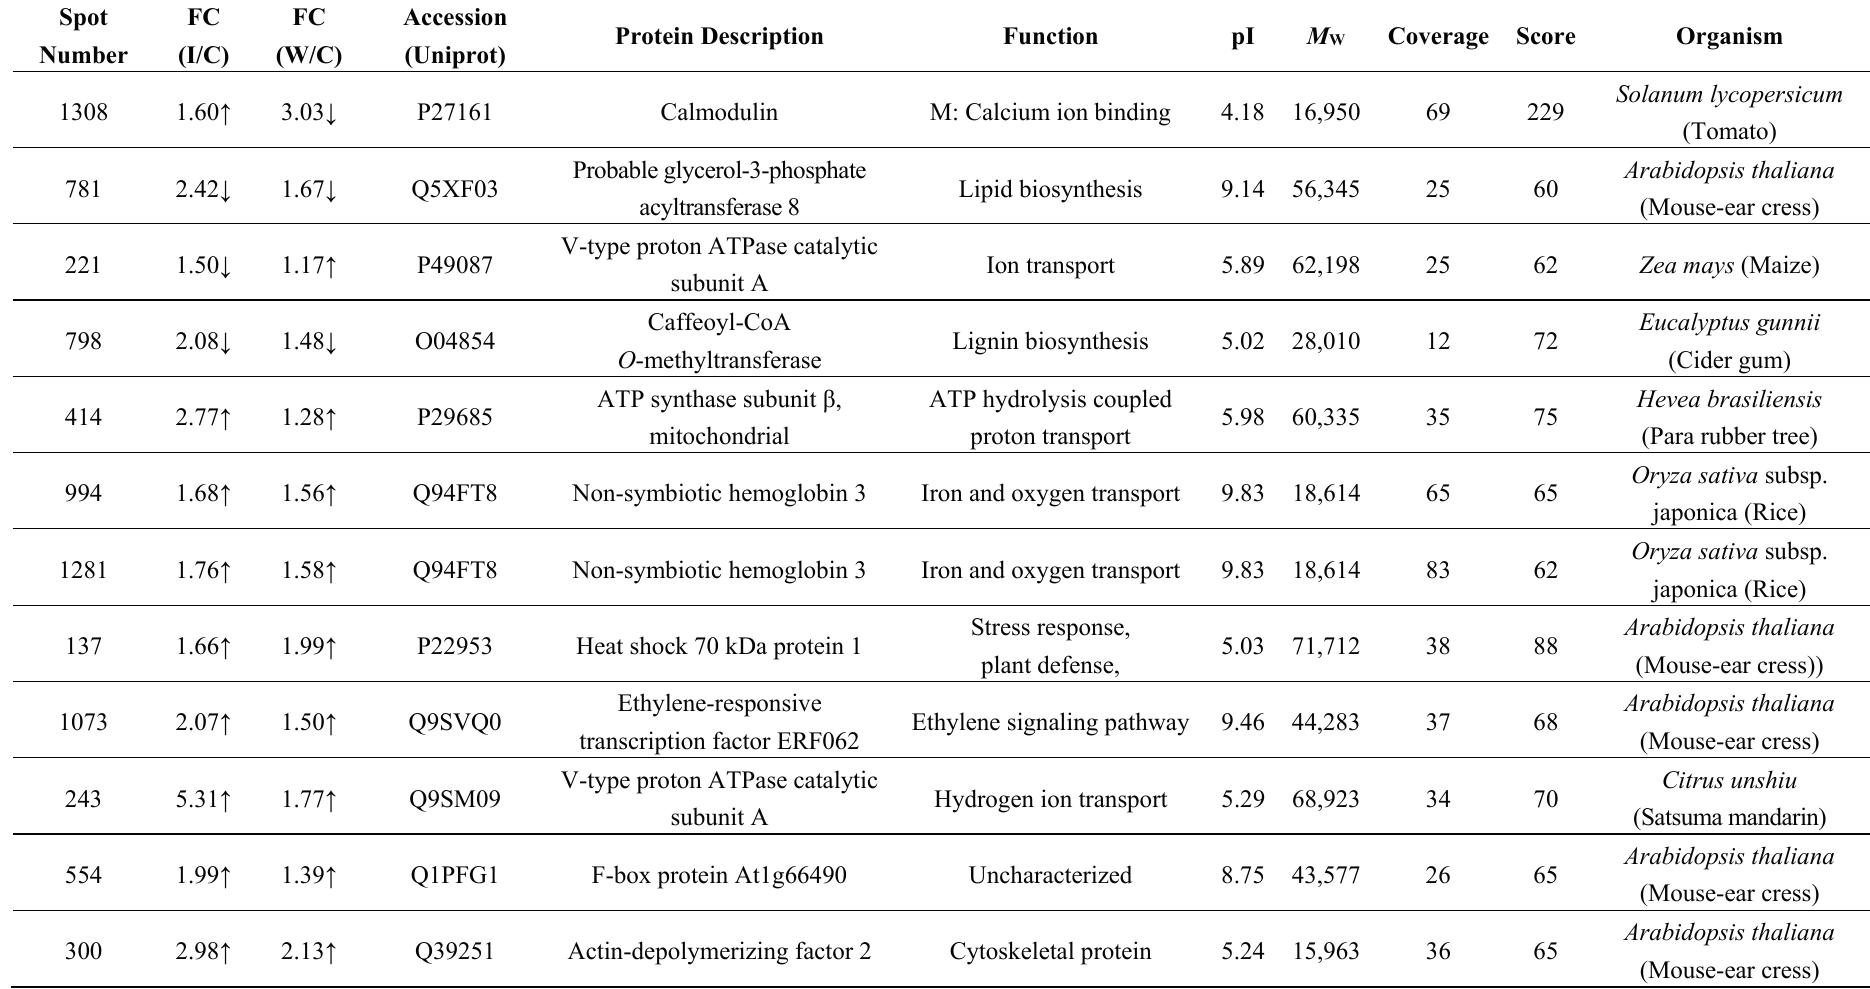
Table 2. Differentially expressed proteins between control, wounded and infested date palm stem by MALDI-TOF peptide mass fingerprinting after